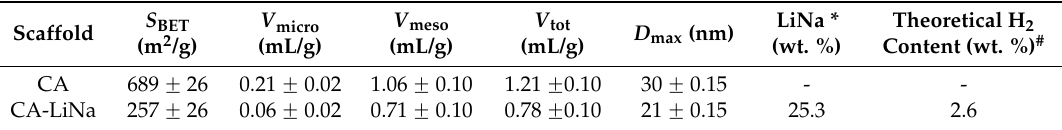
Table 1. Texture parameters of as prepared carbon aerogel scaffold (CA). The gravimetric hydrogen content of the confined sample is also